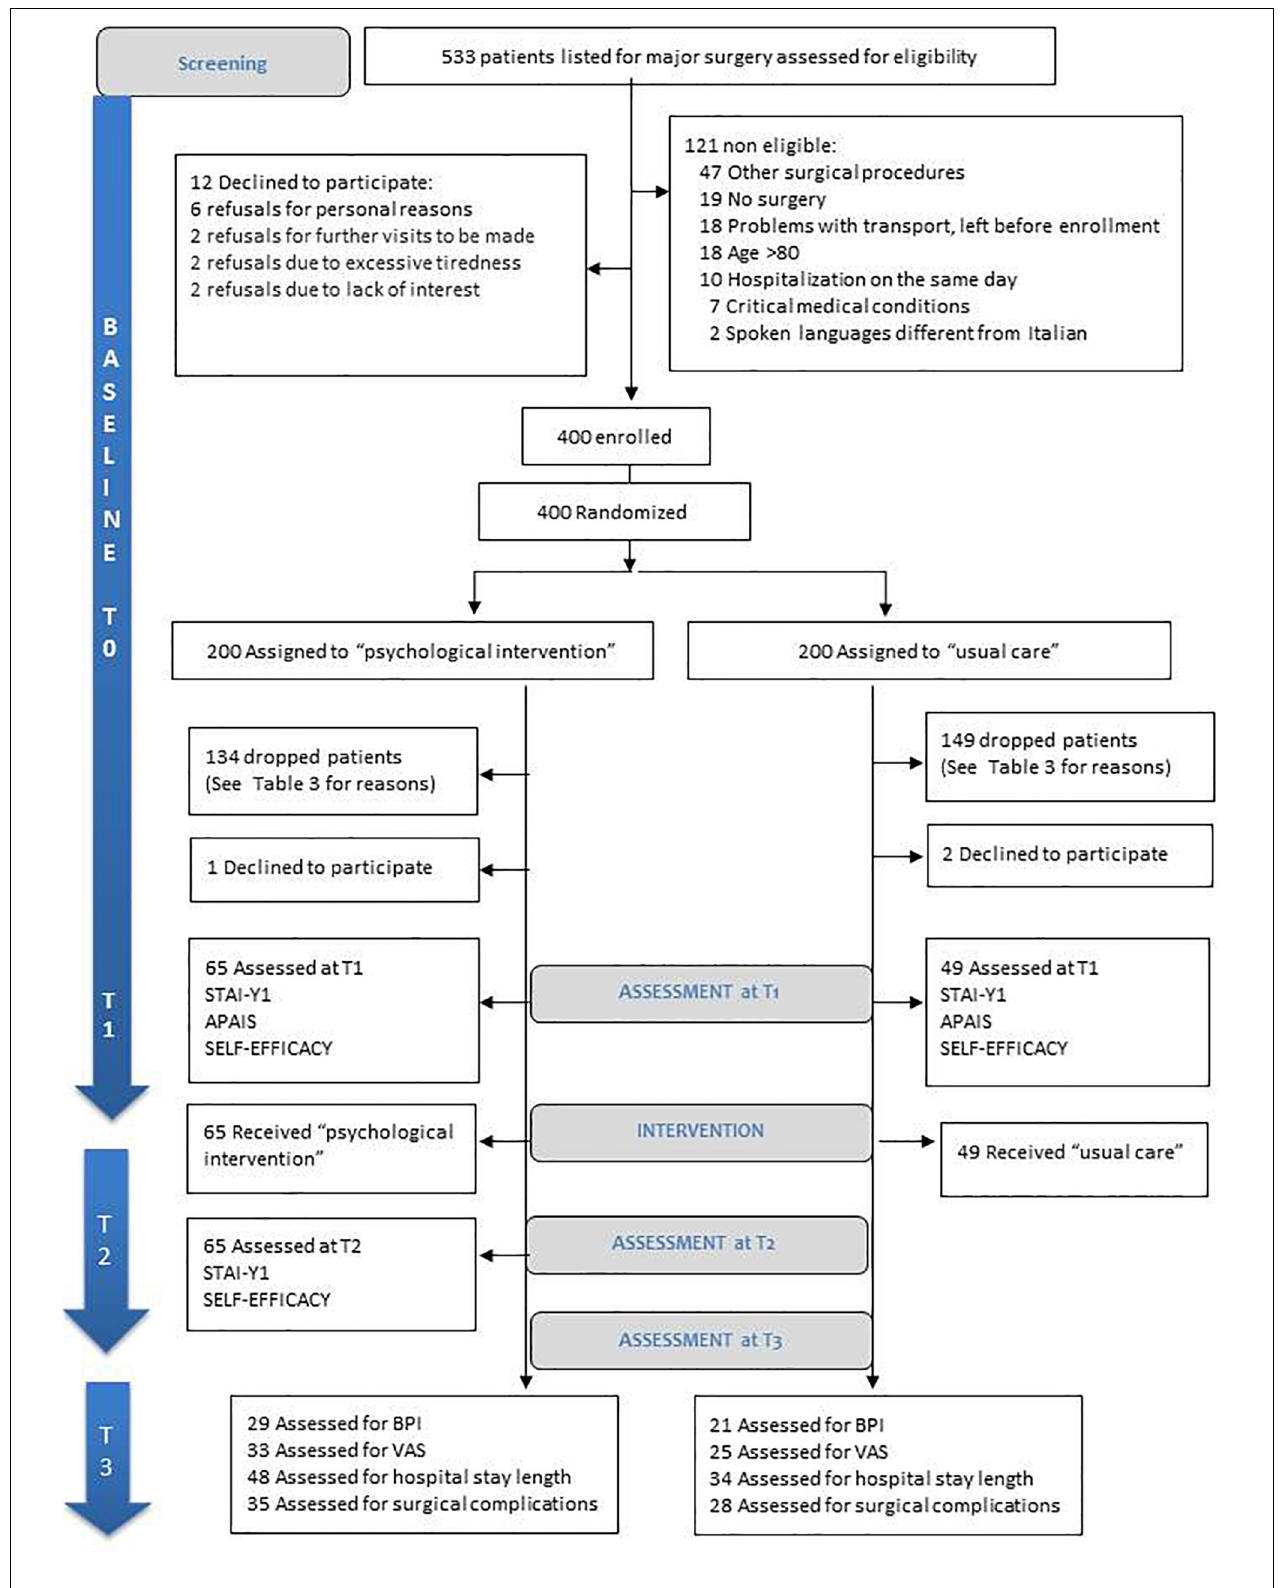
FIGURE 3 | CONSORT (Eldridge et al., 2016) diagram of patient recruitment.